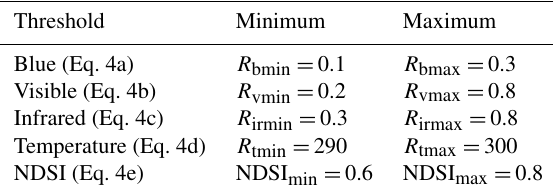
Table 2. Parameters for Landsat simple cloud score, Eqs.